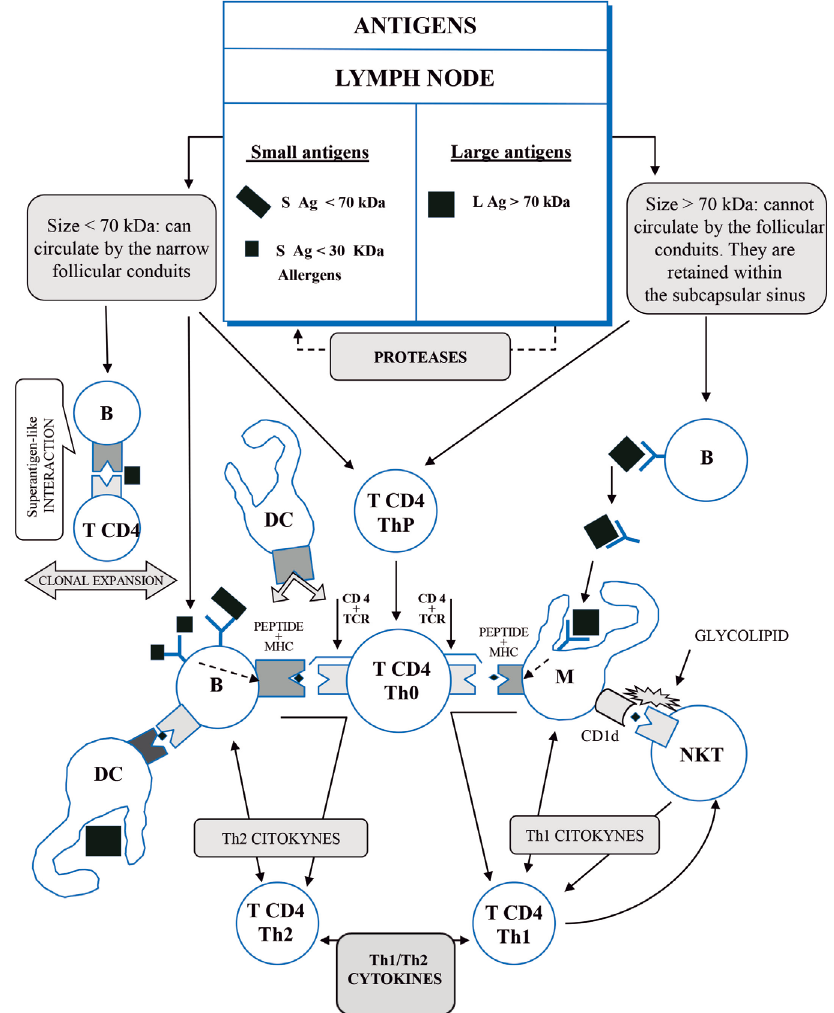
Figure 1. The antigens presentation pathways of different sizes. B: lymphocyte B; M: macrophage; DC: dendritic cell; CD4: cluster of quadruple differentiation; T CD4 ThP: lymphocyte T4 helper precursor; T CD4 Th0: naive lymphocyte T4 preactivated; T CD4 Th1: lymphocyte T4 helper 1 activated; T CD4 Th2: lymphocyte T4 helper 2 activated; CD1d: cluster differentiation 1d